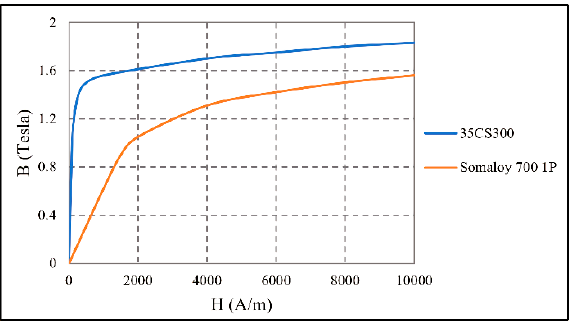
Figure 2. Magnetization curves of silicon steel (35CS300) and Somaloy 700 1P .